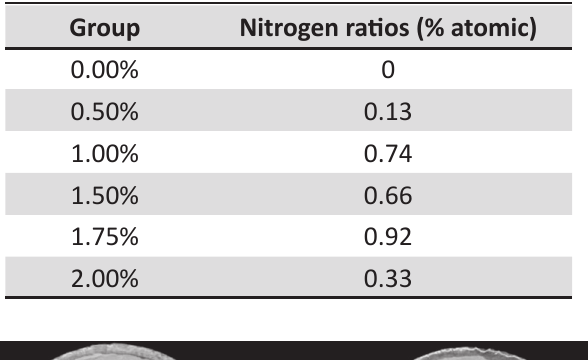
Table 2- Nitrogen ratios on specimen’s surface